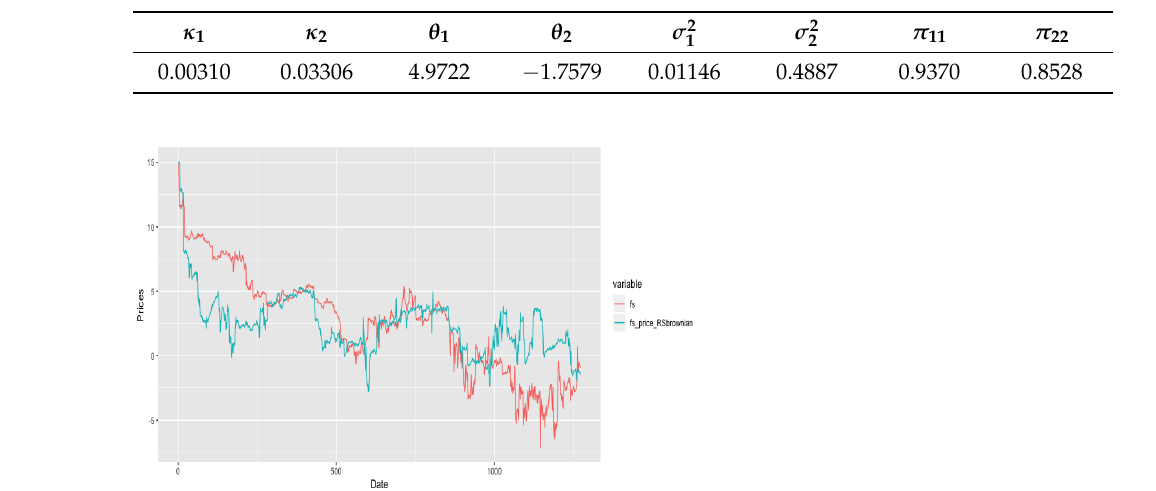
Table 4. Estimation result of RSOU for fuel-switching data.